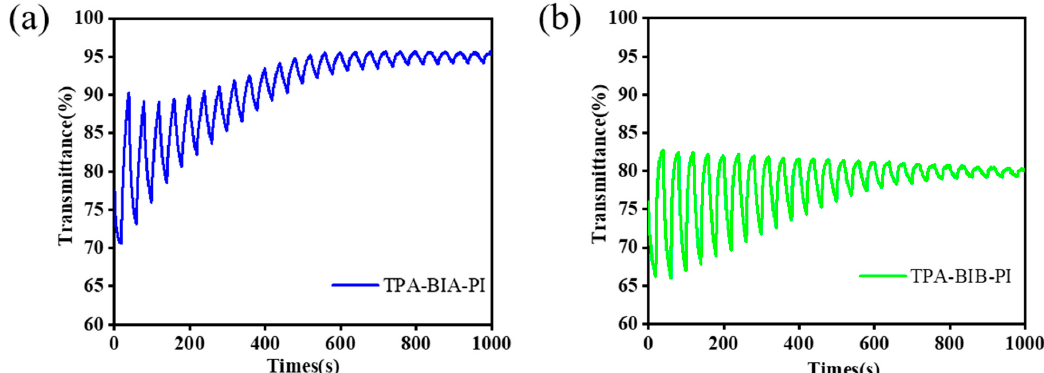
Figure 11. Optical switching time of TPA-BIA-PI at 755 nm ( a ) and TPA-BIB-PI at 762 nm ( b ). 3. Experimental 3.1. Materials 2,4-Dinitrodiphenylamine and 4-nitro-o-phenylenediamine are used as starting mon- omers for two synthetic routes. Among them, 2,4-dinitrodiphenylamine (TCI), 4-Nitro- benzoyl chloride (TCI), 4-nitro-1,2-phenylenediamine (Shanghai Energy Chemical Co., Ltd., Shanghai, China), benzoyl chloride (Shanghai Aladdin Chemical Co., Ltd., Shanghai, China) and pyridine (Shanghai Aladdin Chemical Co., Ltd.) are all used as accepted. Pd/C and acetic anhydride were procured from Sinopharm Chemical Reagent Beijing Co., Ltd. Cesium fluoride, triethylamine, 4-Fluoronitrobenzene, ethanol, tetrahydrofuran, acetic acid, dimethyl sulfoxide (DMSO) and N,N-dimethylacetamide (DMAc) were procured from Shanghai Titan Scientific Co., Ltd. In addition, ethanol, tetrahydrofuran, acetic acid, dimethyl sulfoxide (DMSO) and N,N-dimethylacetamide (DMAc) were purified by vacuum distillation and stored over 4 Å molecular sieves before use. The synthesized di- amine monomer and commercial 4,4’-(Hexafluoroisopropylidene) phthalic anhydride were treated in a vacuum oven at 180 °C for water removal before use. 3.2. Synthesis of Compounds 3.2.1. Synthesis of 1,2-Diphenyl-N,N’-di-4-nitrophenyl-5-amine benzimidazole (TPA- BIA-NO 2 ) A mixture of 1,2-Diphenyl-5-aminobenzimidazole (8.8 g, 31 mmol), 4-Fluoronitro- benzene (13.1 g, 93 mmol) and cesium fluoride (16.5 g, 108 mmol) in 90 mL of DMSO was